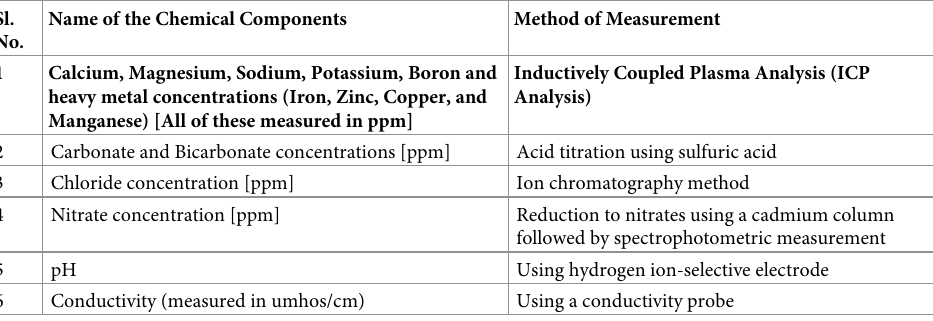
Table 1. Method for measurement of chemical parameters used in Texas A&M Soil, Water and Forage Testing Laboratory, College Station, TX [27–35].